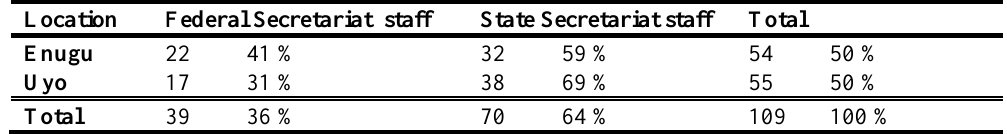
Table 2. Administered Questionnaires to the Respondents (developed by the authors) Location